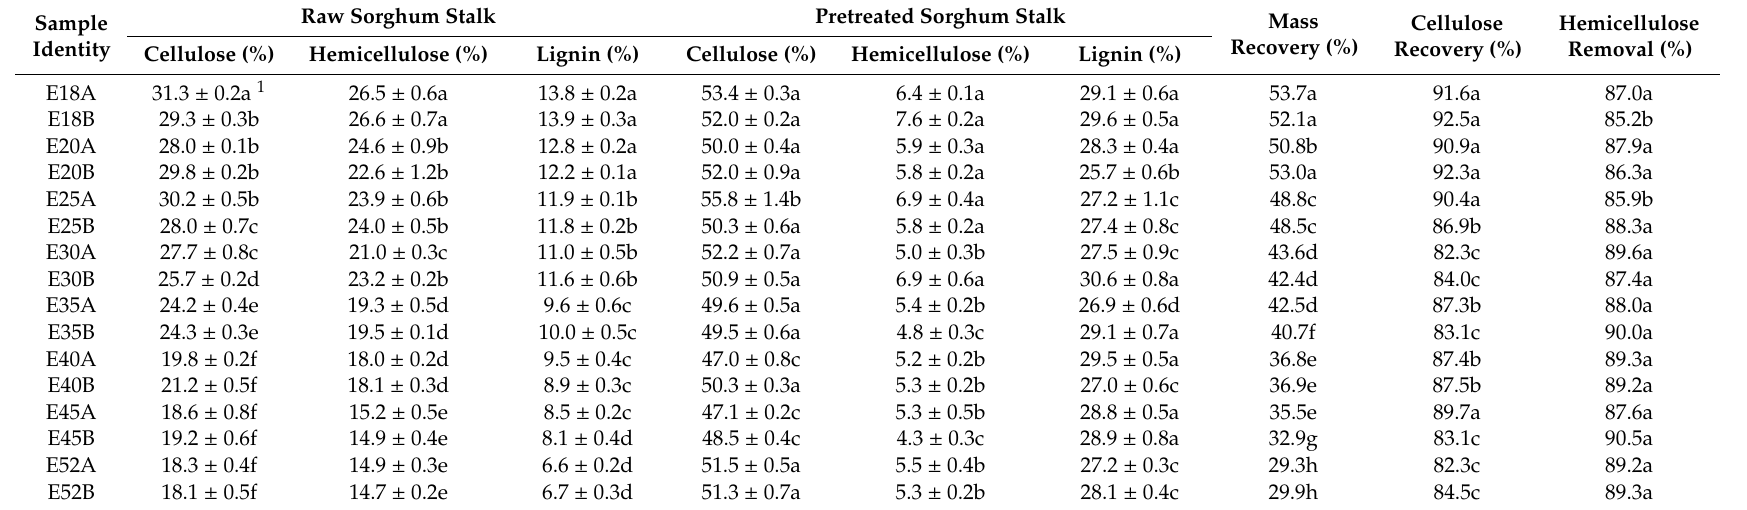
Table 3. Chemical composition of sorghum stalks before and after